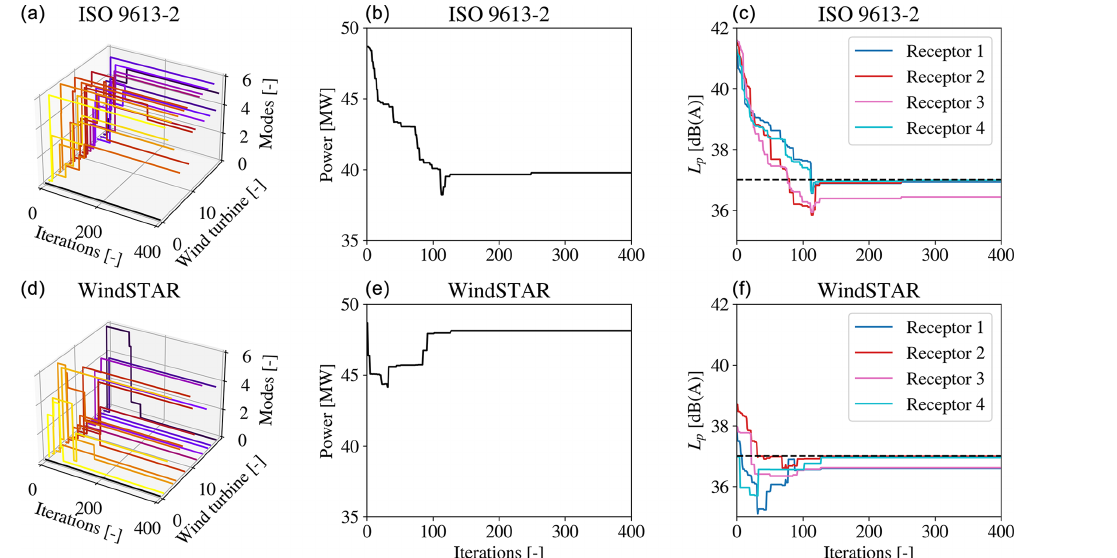
Figure 16. The operational mode, m i , for each wind turbine (a, d) ; the overall power of the 4 × 5 SWT-DD-142 wind turbines (b, e) ; and the integrated sound pressure level, L p ,j , at each receptor (c, f) during the optimization at θ = 225 ◦ and U hub = 10ms − 1 . The noise constraint is set to L p , lim ,j = 37dB(A) and represented by the dashed line in the right figure.